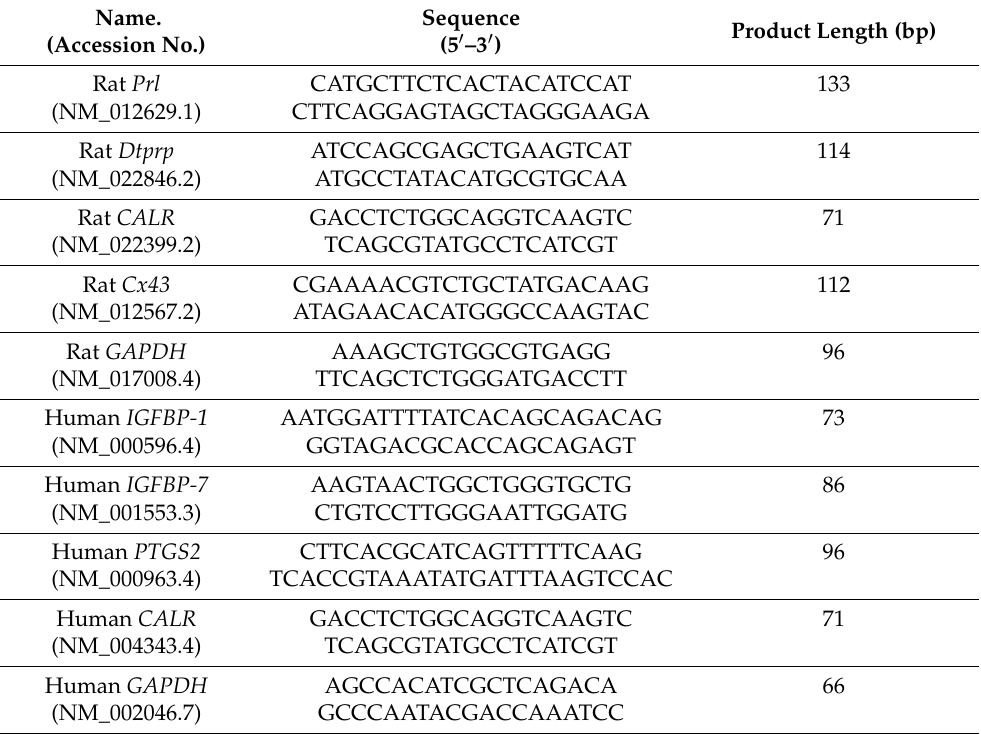
Table 1. Primers for real-time PCR